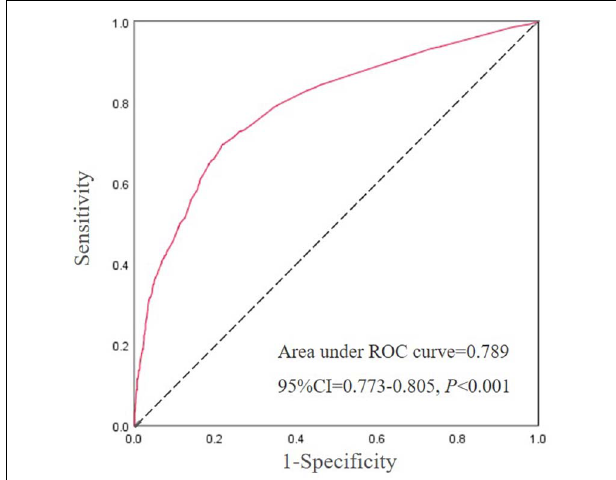
FIGURE 1 | The ROC curve for the influence factors of Table 4 . Abbreviations: NAFLD, non-alcoholic fatty liver disease; AUROC, area under the receiver operating curve. The response variable is NAFLD risk and the diagnostic test variable is a combination of age, visceral obesity, ALT, γ -GT, hypertriglyceridemia, hypertension, low HDL-C, hyperglycemia, and unfavorable alleles with the coefficients taken from the regression